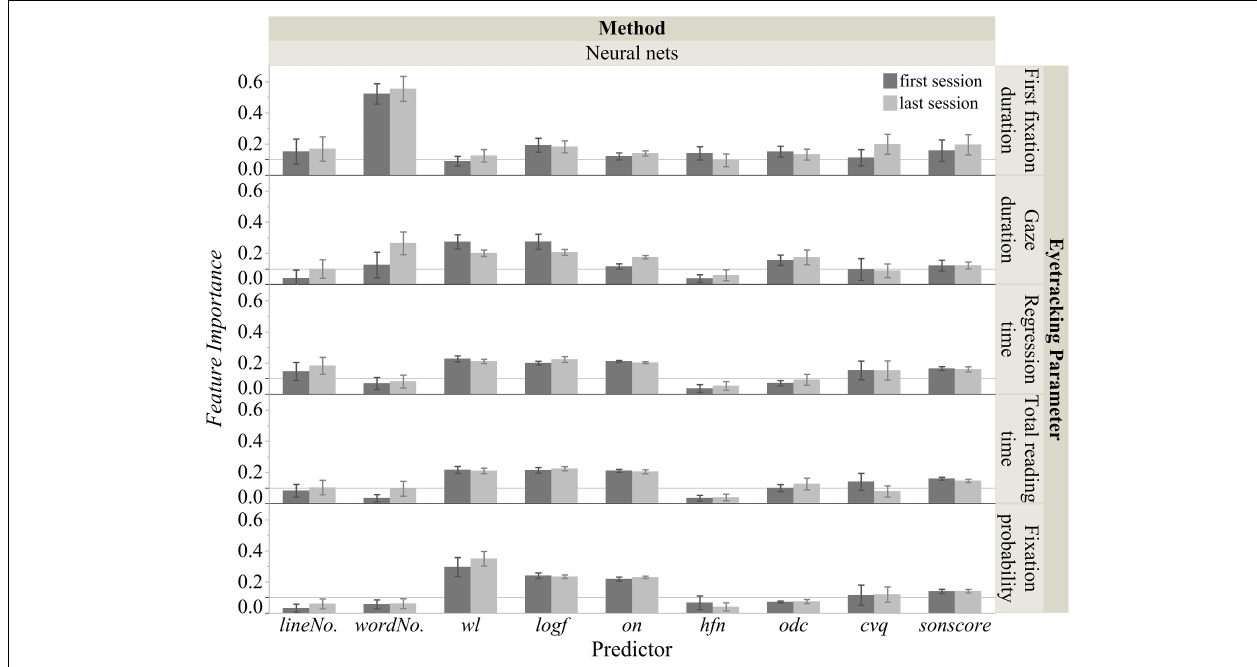
FIGURE 5 | Feature importance for the five eye tracking